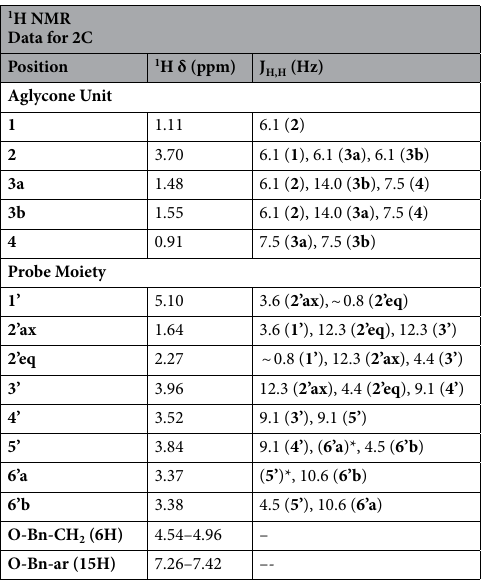
Table 4. Chemical proton shifts and coupling constants for molecule 2C second. *These coupling constants could not be measured. Signal pattern remains partially unclear due to serve signal overlap and higher order effects.